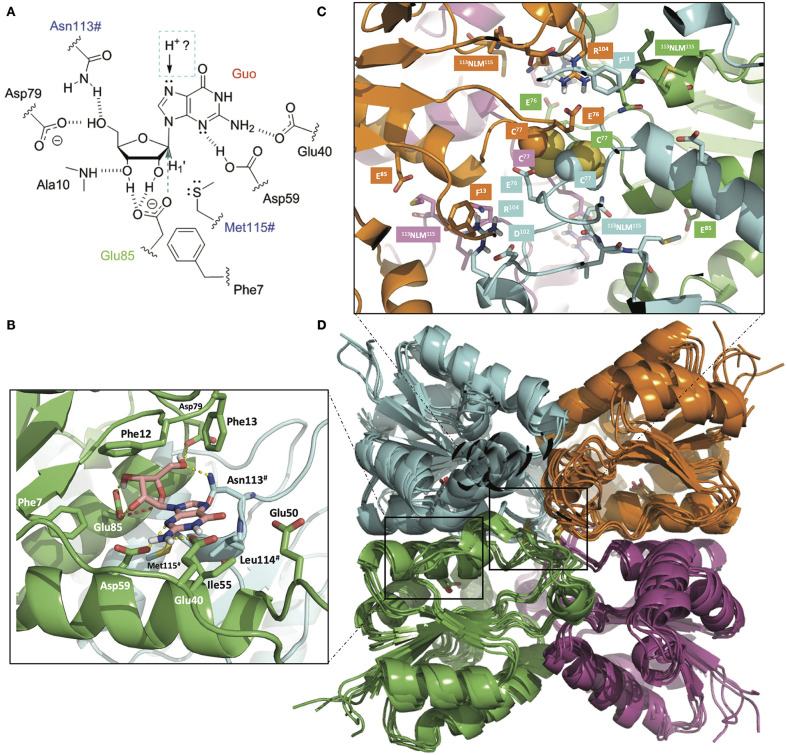
(A) Schematic of the binding of guanosine (Guo) to the active site of AvNRT. Asn113# and Met115# from the NLM motif (in blue) belong to another monomer making up the obligate dimer that is necessary for nucleobase and sugar recognition. The catalytic glutamate (Glu85) is colored in green and the direction of attack to C1' is indicated by an arrow. The nature of the proton donor to N7, either from the same dimer or from the other dimer making up the tetramer, is presently unknown. (B) 3D view of the active site in a homology model of AvNRT. Note the hydrogen bonds (dashed yellow lines) that help orienting the carboxylate of the catalytic Glu85 for nucleophilic attack on C1' (red broken line). Enzyme residues relevant for the discussion are shown as sticks and have been labeled. (C) Detail of the two disulfide bonds involving Cys77 (Cβ and S atoms are shown in space-filling representation) putatively found at the core of the tetramer comprising dimers A:B (green:cyan) and dimers C:D (magenta:orange). Note their central positioning and proximity to the four NLM motifs and the catalytic Glu85 (sticks). This arrangement is likely to have a bearing on the catalytic activity due to mutual conformational dependencies of both monomers and dimer of dimers. (D) Overlaid ensemble of five AvNRT tetramers obtained after the molecular dynamics equilibration of the initial structure and subsequent simulated annealing procedure. Note how the side chain phenyl ring of Phe13 in each monomer provides a suitable flat surface for a stacking interaction with the guanidinium of Arg104 from the equivalent monomer in another dimer, hence contributing to tetramerization. Glu76 and Asp102 are proposed to contribute to dimer and tetramer stabilization by providing a buttressing effect to Arg104. The cartoon representation of the four individually colored monomers and the display of the disulfides as sticks are used for simplicity and ease of visualization. The figure was prepared with PyMOL (Delano, 2002) using ray tracing.